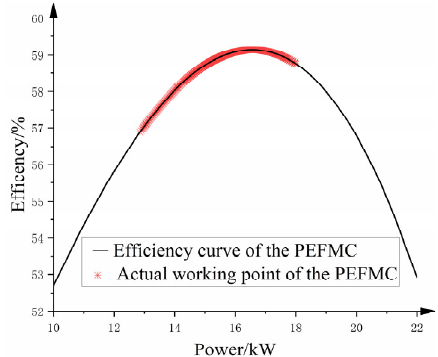
Figure 14. The actual working point of the hydrogen fuel cell.